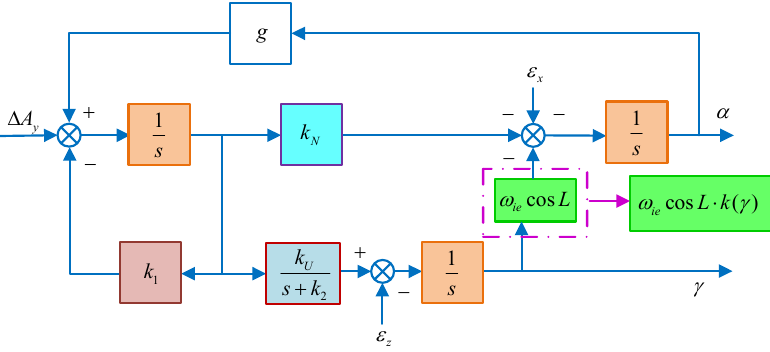
Figure 4. The diagram of the gyrocompass alignment in the north